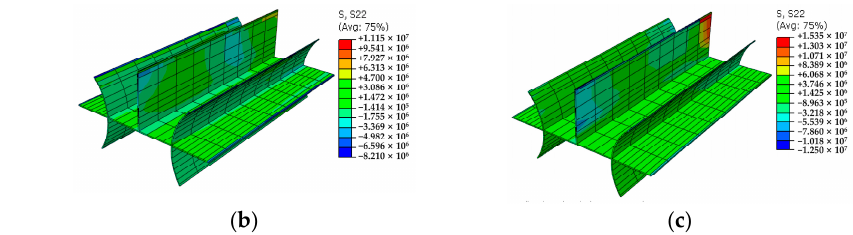
Figure 12. The vertical stress of the temporary support in different conditions (unit: Pa): ( a ) Condi-